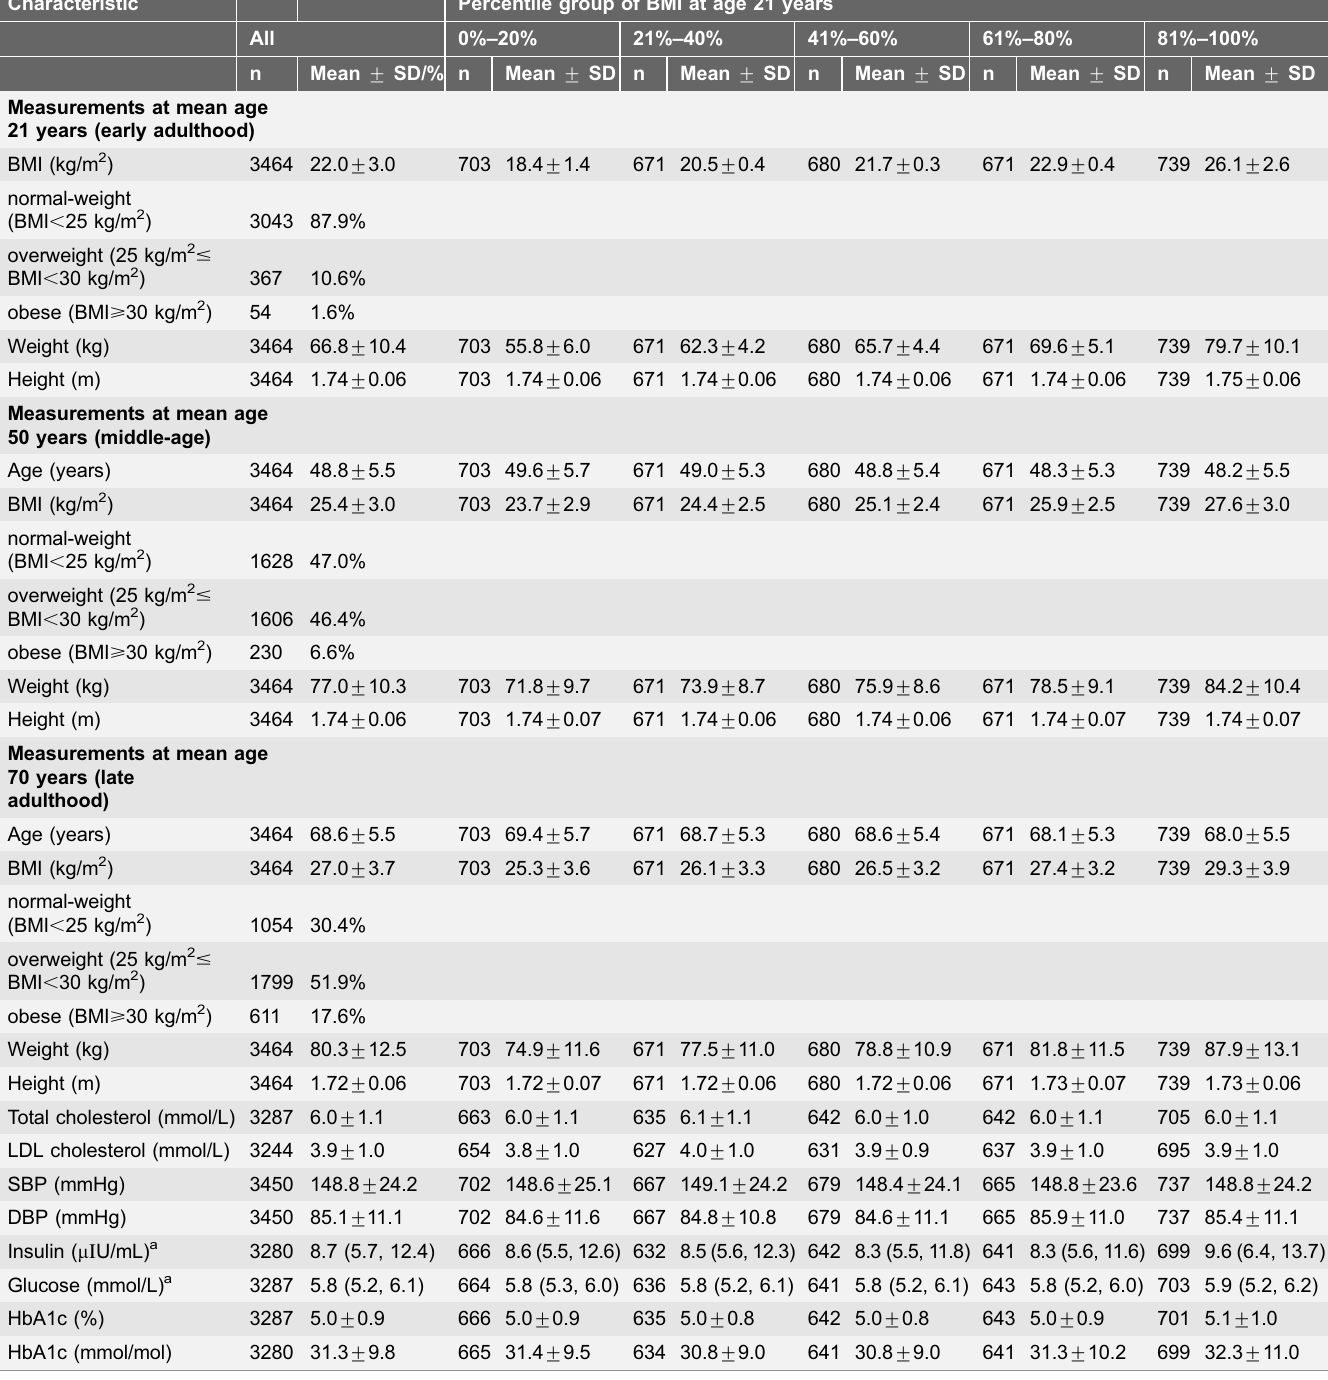
Table 1. Cohort characteristics in early, middle, and late adulthood in all men, and by quintile of BMI in early adulthood.